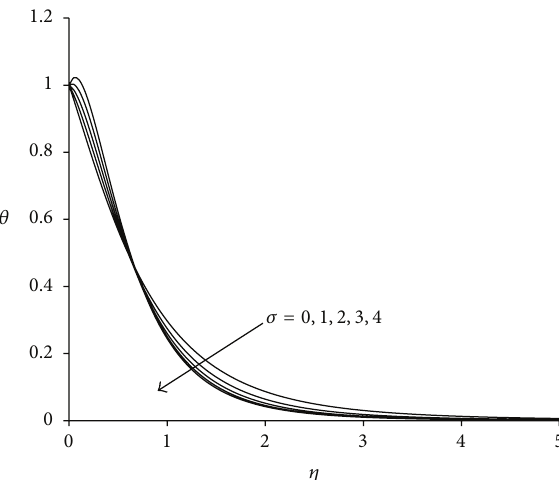
Figure 10: Temperature distribution for different 𝜎 (𝜆 = 3, 𝜏 = 1, Ec = 0.75) .